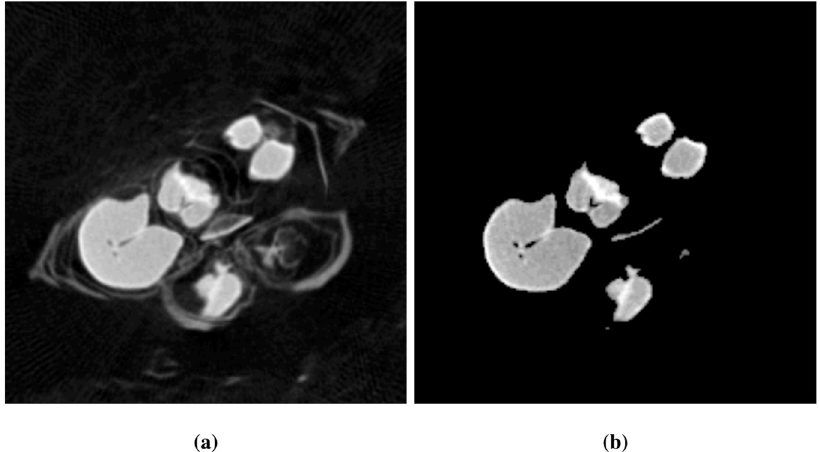
Figure 9. Foreground detection by GMM. ( a ) The raw CT image; ( b ) Image after threshold segmentation.